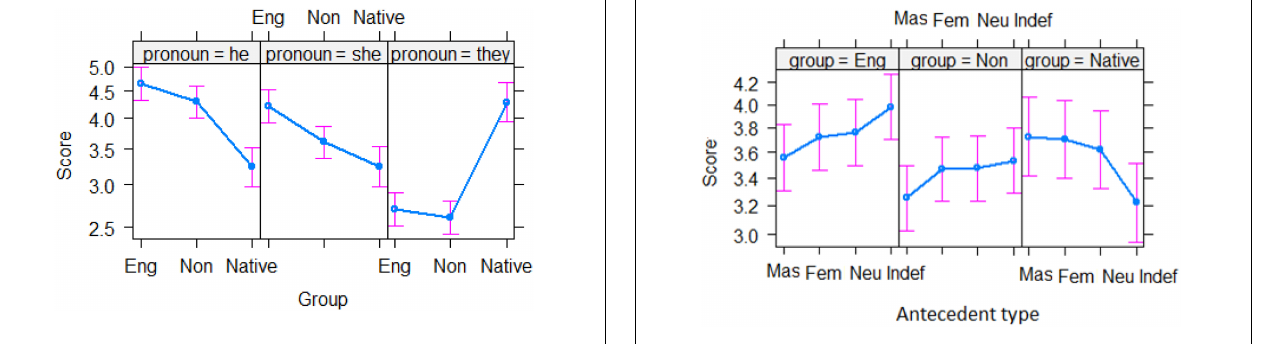
FIGURE 3 | The interaction between group and pronoun . ( Eng , English majors; Non , non-English majors; Native , native English speakers).